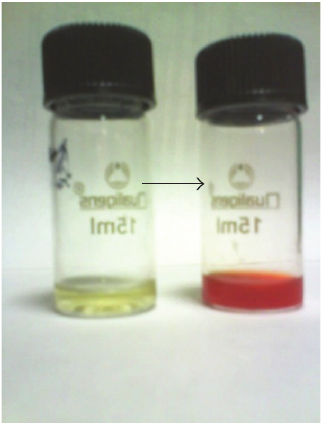
F 1: Colour change in reaction mixture (silver nitrate Tulsi leaves extract) (a) at 0 hours; (b) aer 2 hours.